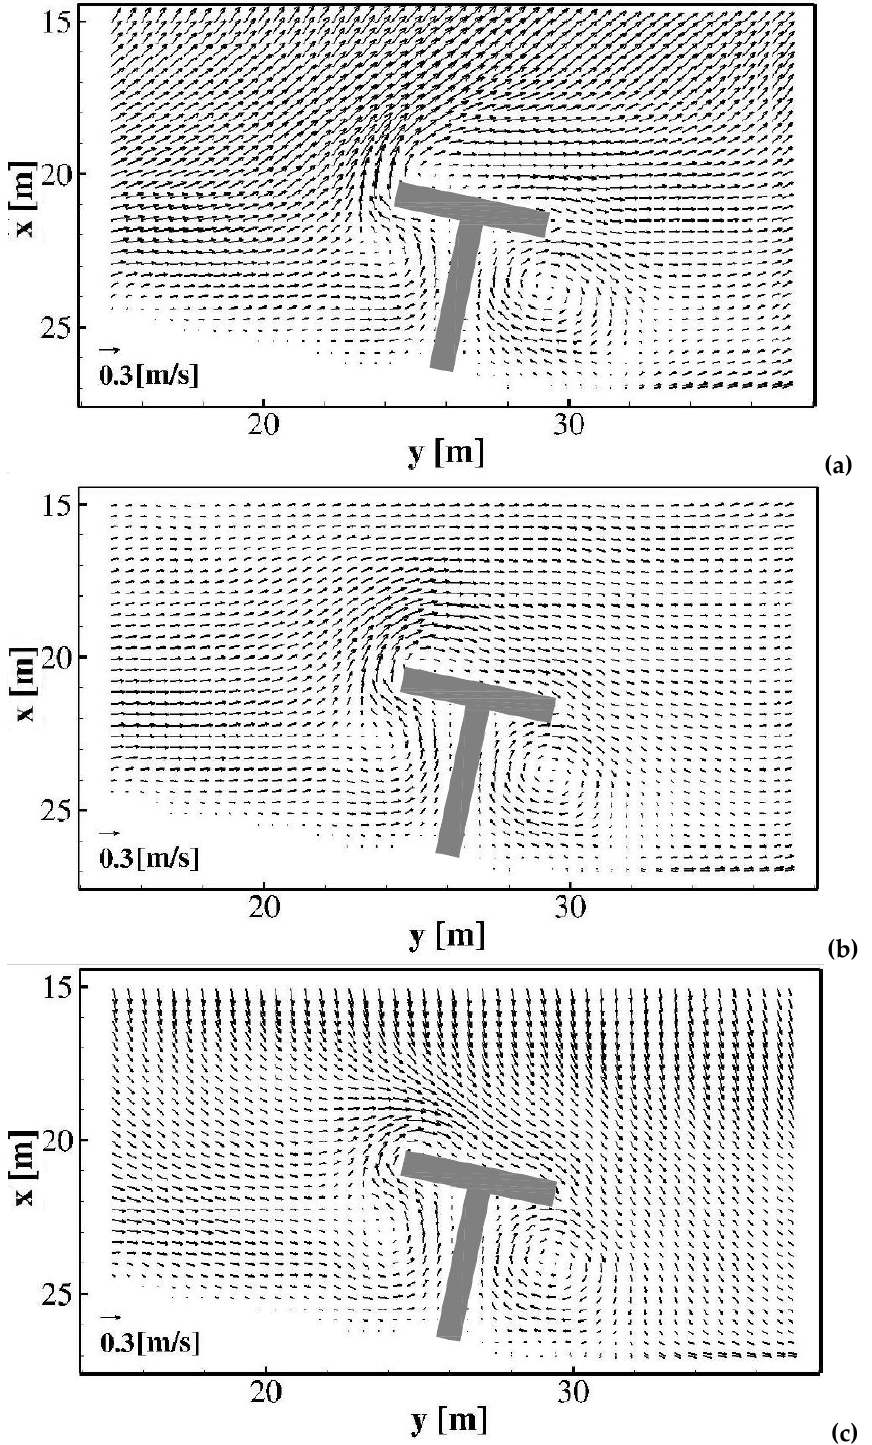
Figure 2. Plan view of the time-averaged velocity field: ( a ) z / z b = 0.894, near the bottom; ( b ) z / z b = 0.488, intermediate position along the vertical direction; ( c ) z / z b = 0.081, near the free